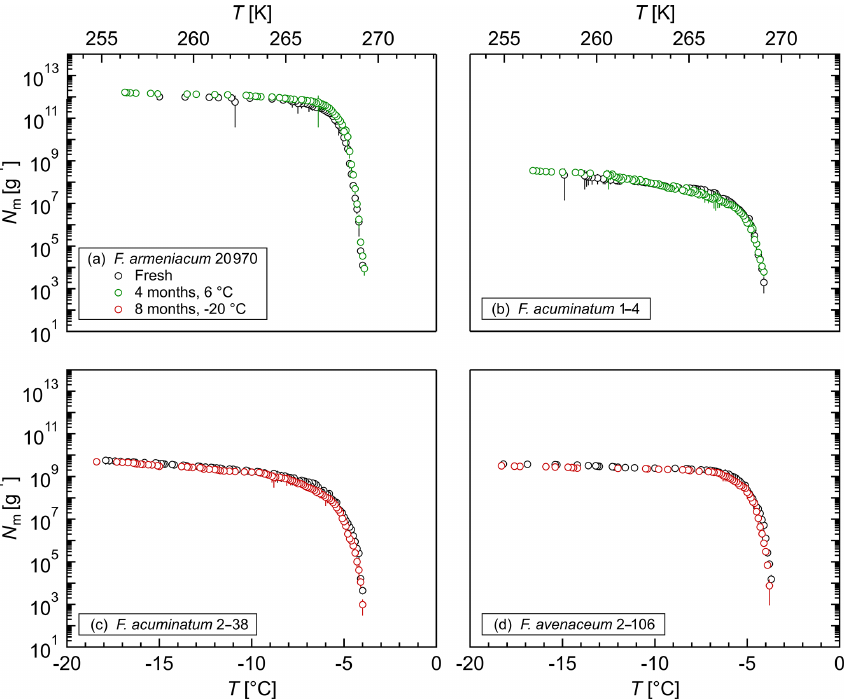
Figure 6. Effect of long-term storage on the ice nucleation activity of (a) F. armeniacum 20970, (b) F. acuminatum 1–4, (c) F. acuminatum 2–38, and (d) F. avenaceum 2–106: cumulative number of IN ( N m ) per gram of mycelium plotted against the temperature ( T ). The error bars were calculated using the counting error and the Gaussian error